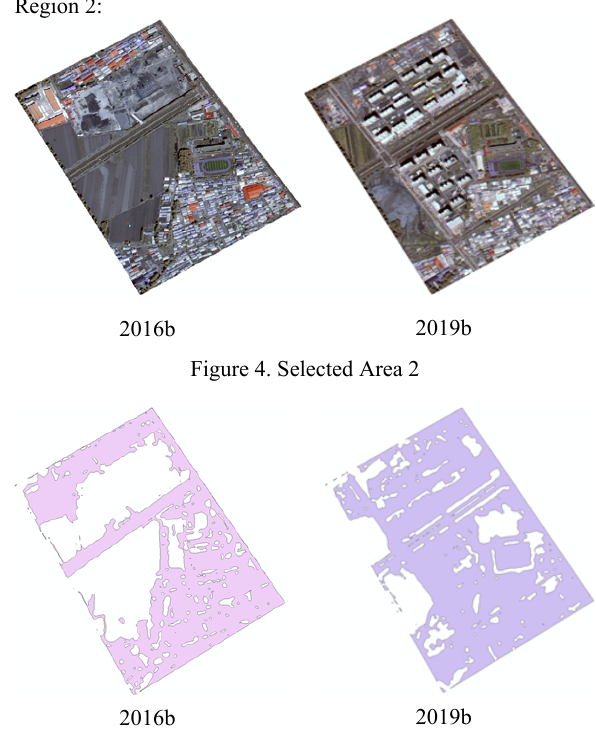
Figure 5. Extraction area 2 impermeable